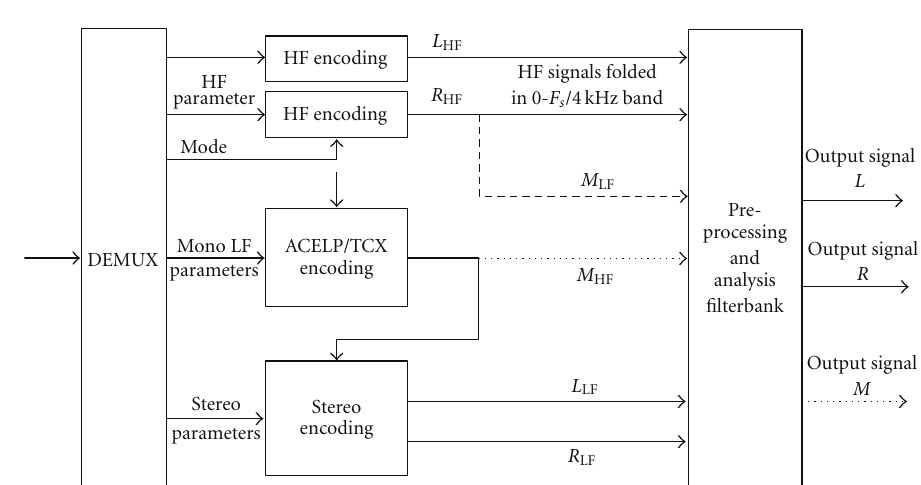
Figure 2: Structure of AVS-M audio